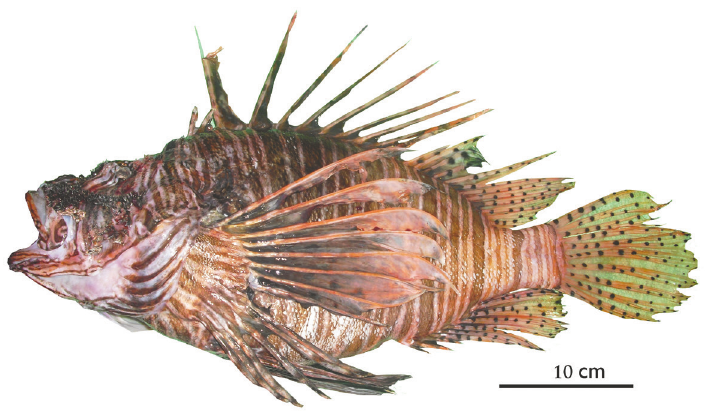
Fig. 1. Mature male specimen of Pterois volitans (457 mm TL) caught from the coastal waters of Margarita Island,